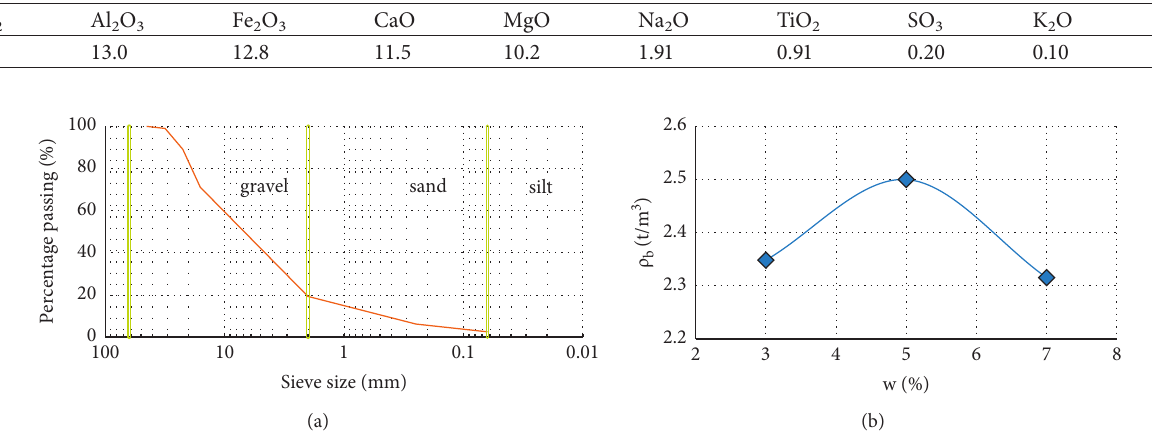
Figure 2: Grain size distribution curve (a) and assessment of OMC (b).